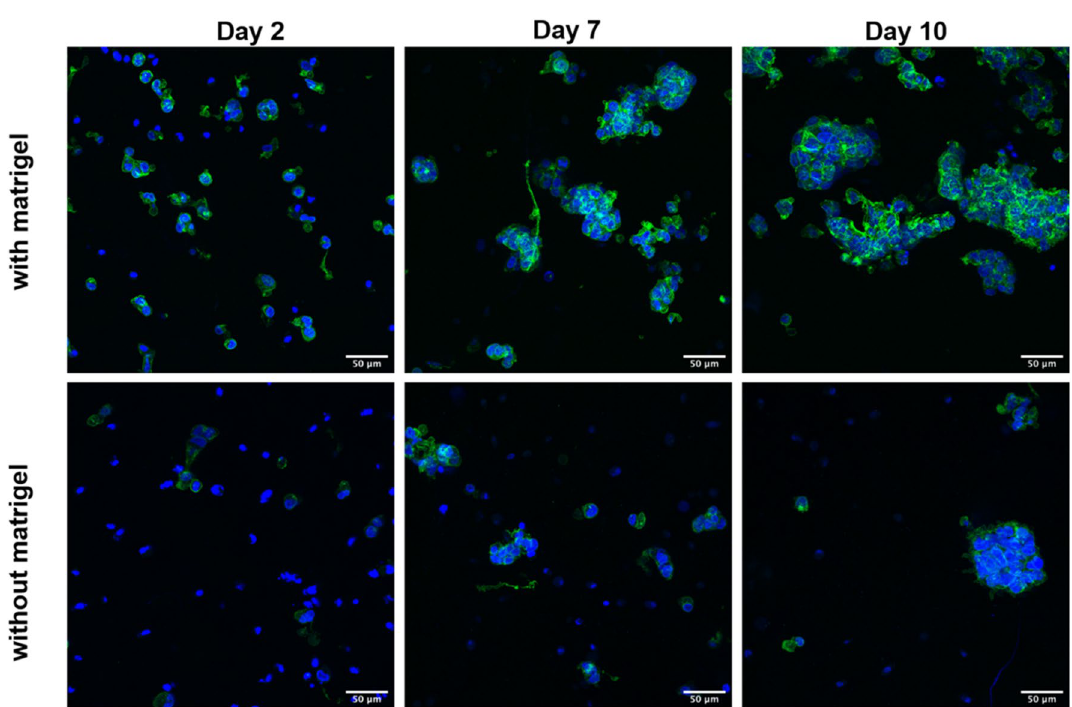
Figure 4. Morphology and organization of HepG2 embedded in algMC with (upper panel) and without Matrigel (lower panel) after 2, 7 and 10 days of cultivation. Cell nuclei are stained in blue (DAPI) while cytoskeletons appear in green (actin staining with Phalloidin-iFluor 488); scale bars represent 50